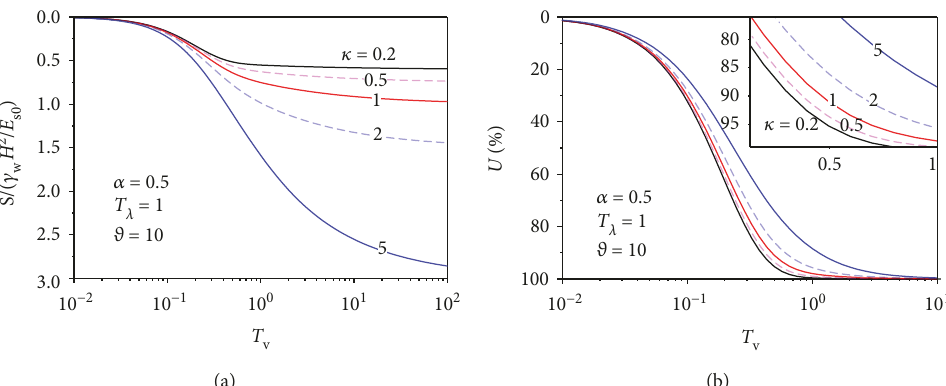
Figure 4: In fl uence of the modulus ratio on the consolidation behavior of the aquifer system. (a) Settlement of aquitard. (b) Degree of consolidation.